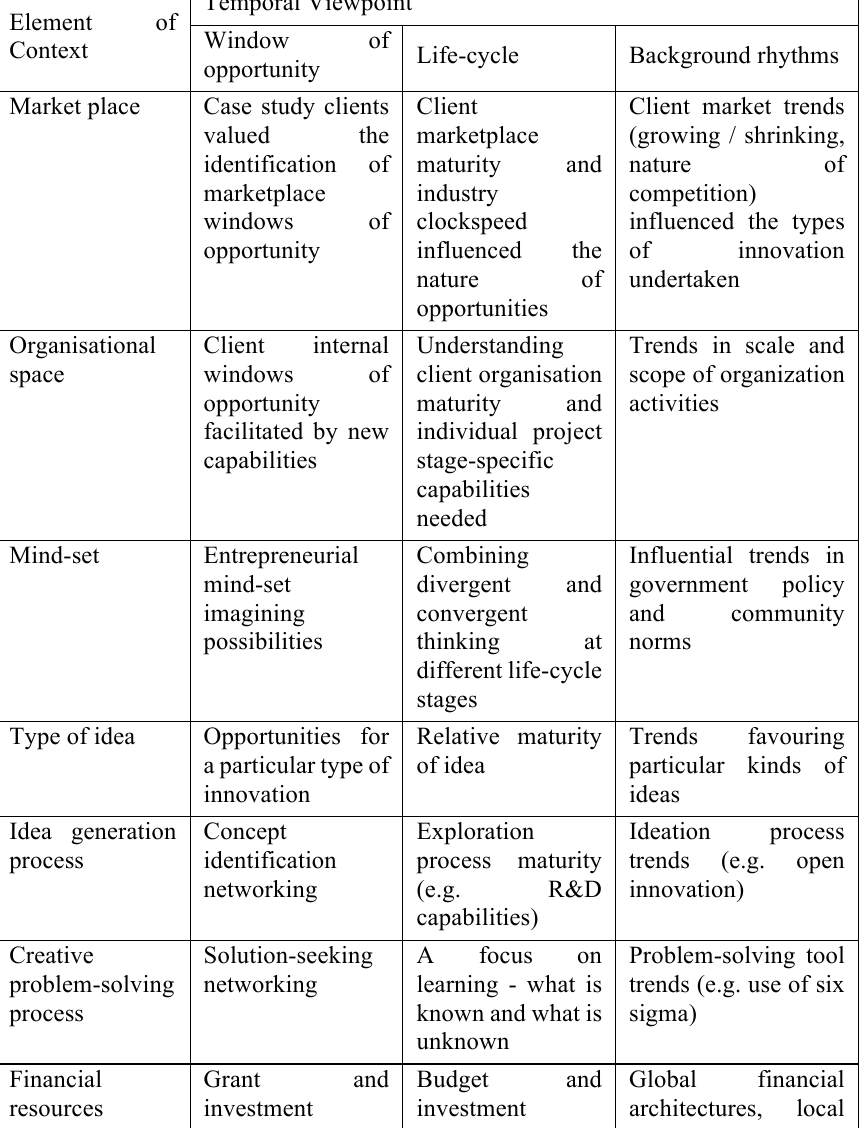
Table 9. Mapping Case study elements of context